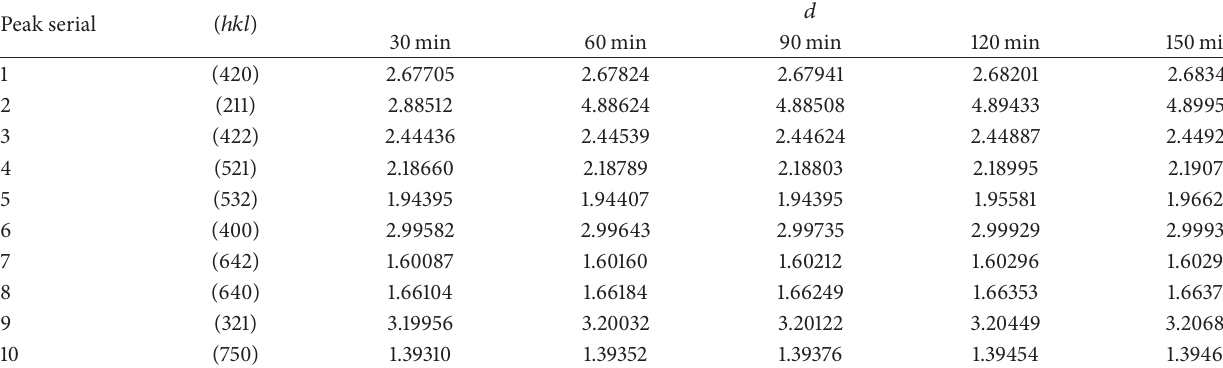
Table 1: 𝑑 values in X-ray diffraction of samples with different holding times.